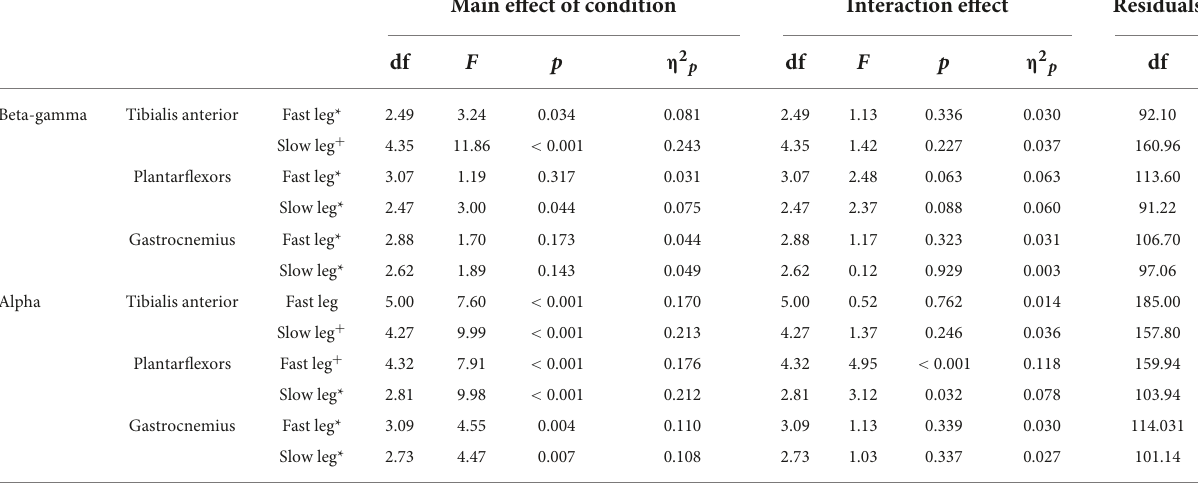
TABLE 4 Main effect of condition and group × condition interaction for coherence. Main effect of